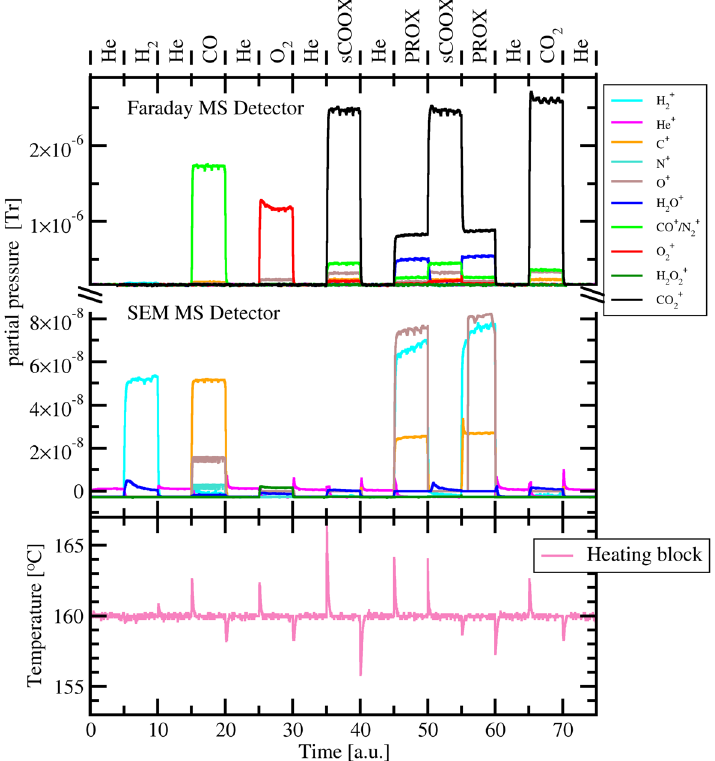
Figure 3. MS probed outlet gas composition and thermocouple measured heating block temperature for the sequential experiment with Au/ CeO 2 catalyst in the PXRD chamber. The time scale corresponds to DP number, with 5 DPs per each gas exposure. One DP measurement lasted about 60 min.